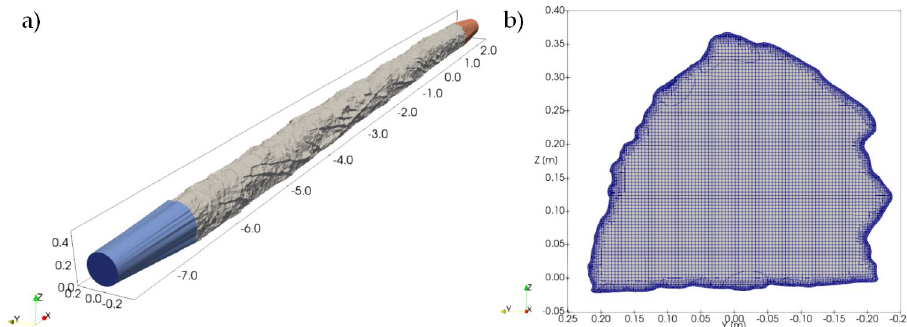
Figure 4. Visualization of modelling domain including inlet- and outlet section (the x -axis [m] is arbitrarily defined in the plot) ( a ) and cross section visualizing the computational grid ( b ).